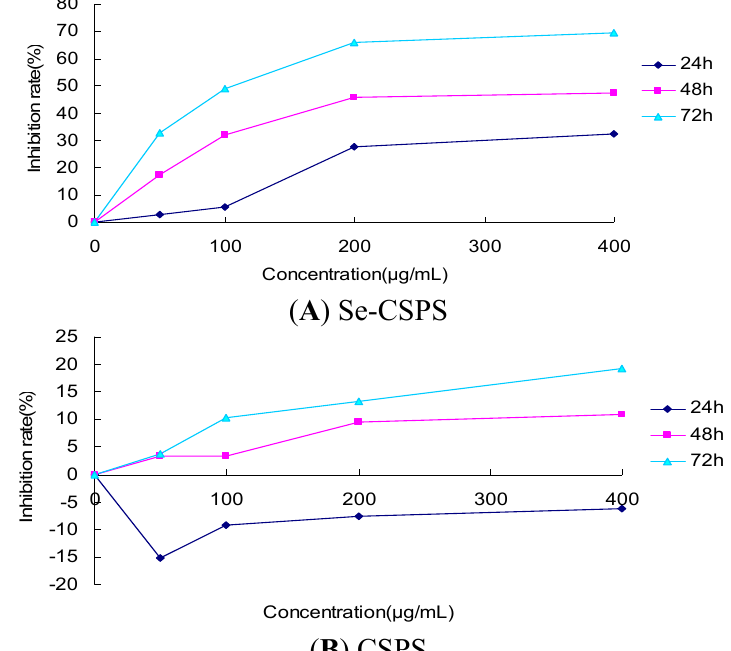
Figure 7. Inhibition effect of ( A ) Se-CSPS; ( B ) CSPS and ( C ) doxorubicin on